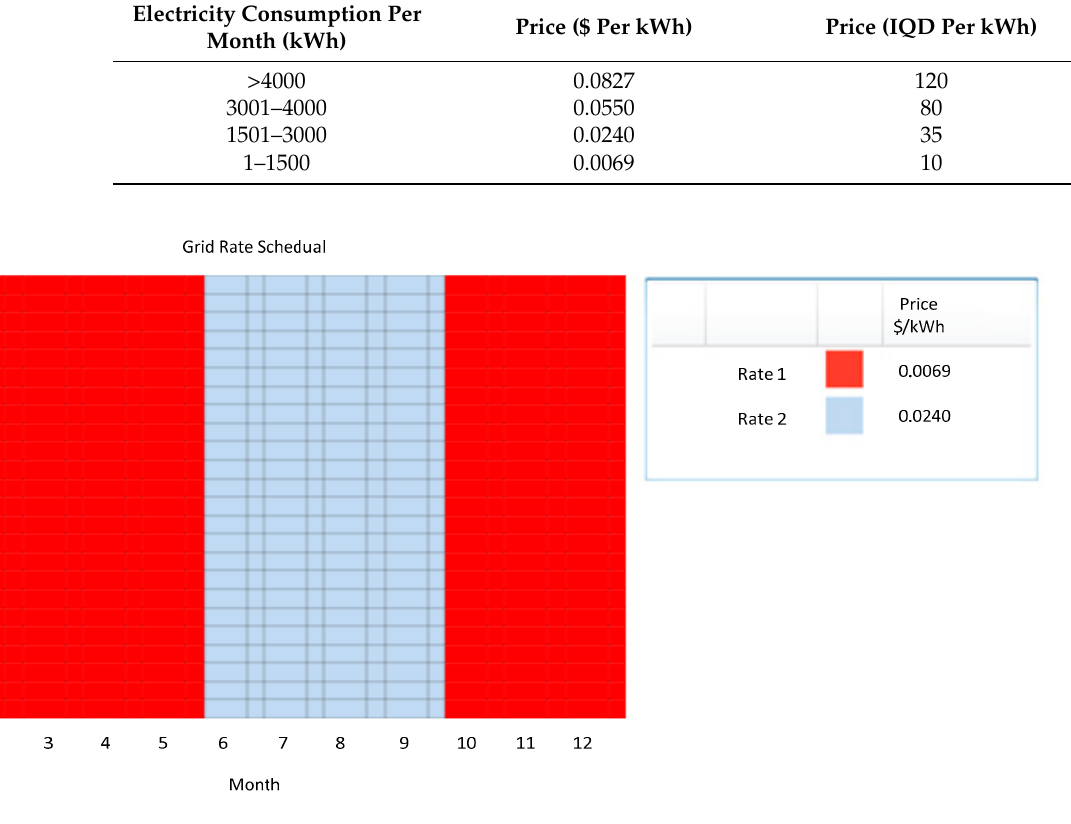
Figure 7. National grid scheduled rates.